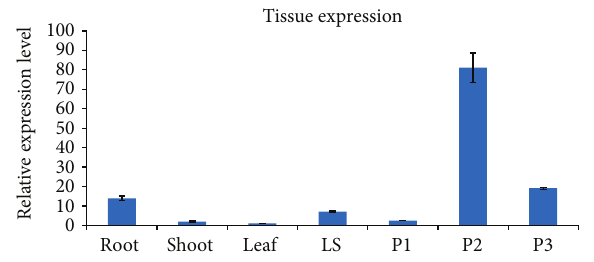
Figure 3: Expression patterns of OsSLI1 in various rice tissues. P1: 3 cm panicles, P2: 8cm panicles, and P3: 12 cm